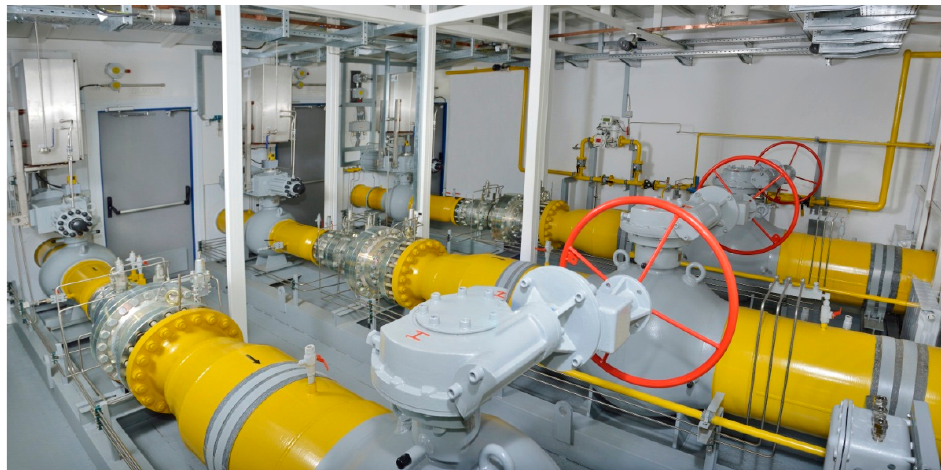
Figure 6. Gas reduction unit.